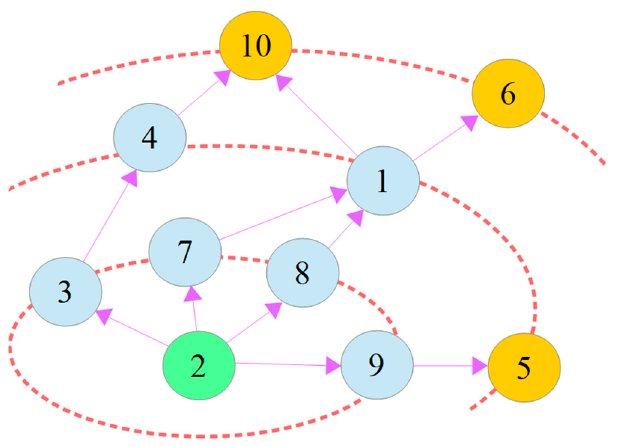
Figure 6. Resulting disassembly wave graph after the application of the 1st method.